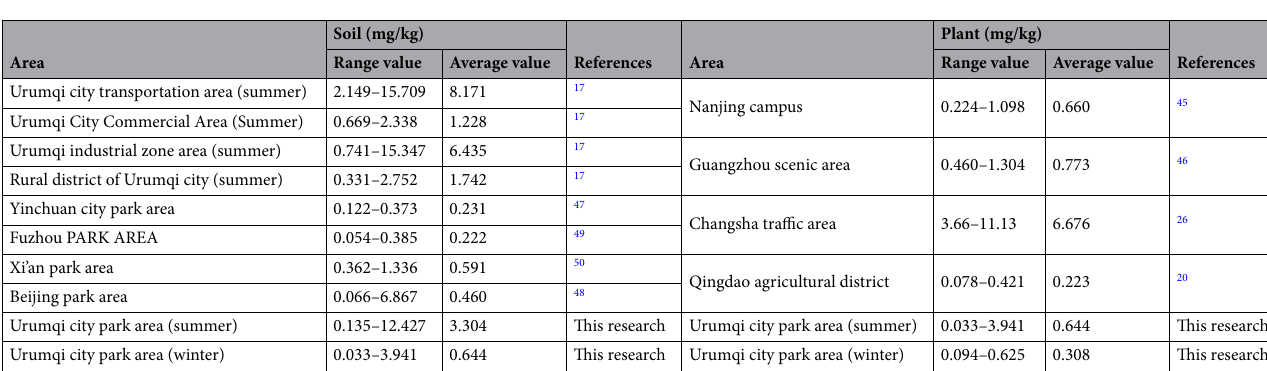
Table 2. The content of PAHs in soil and plants in different